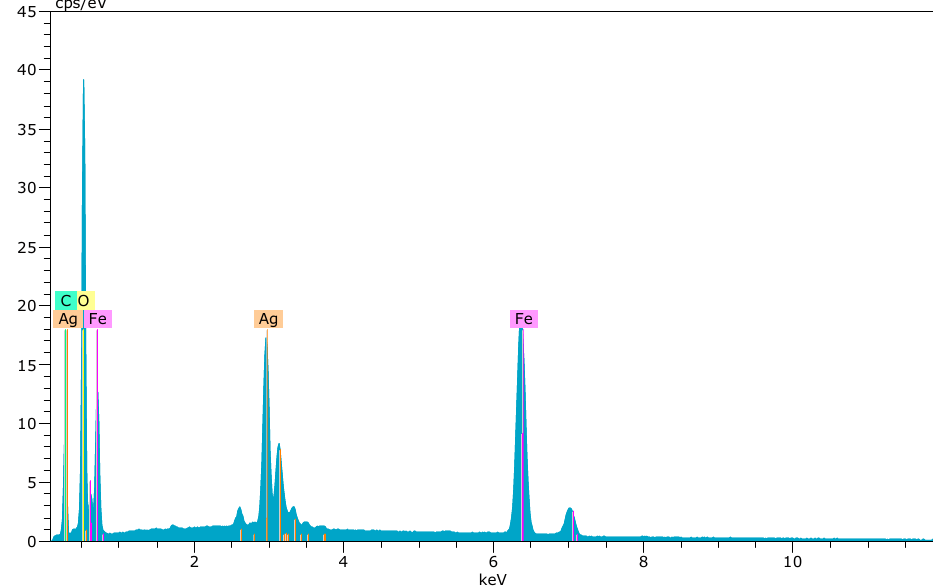
Figure 2. EDX pattern for Fe 3 O 4 @Ag adsorbent. Characteristic peaks for Ag (2.984 keV), Fe (0.705 and 6.398 keV), and O